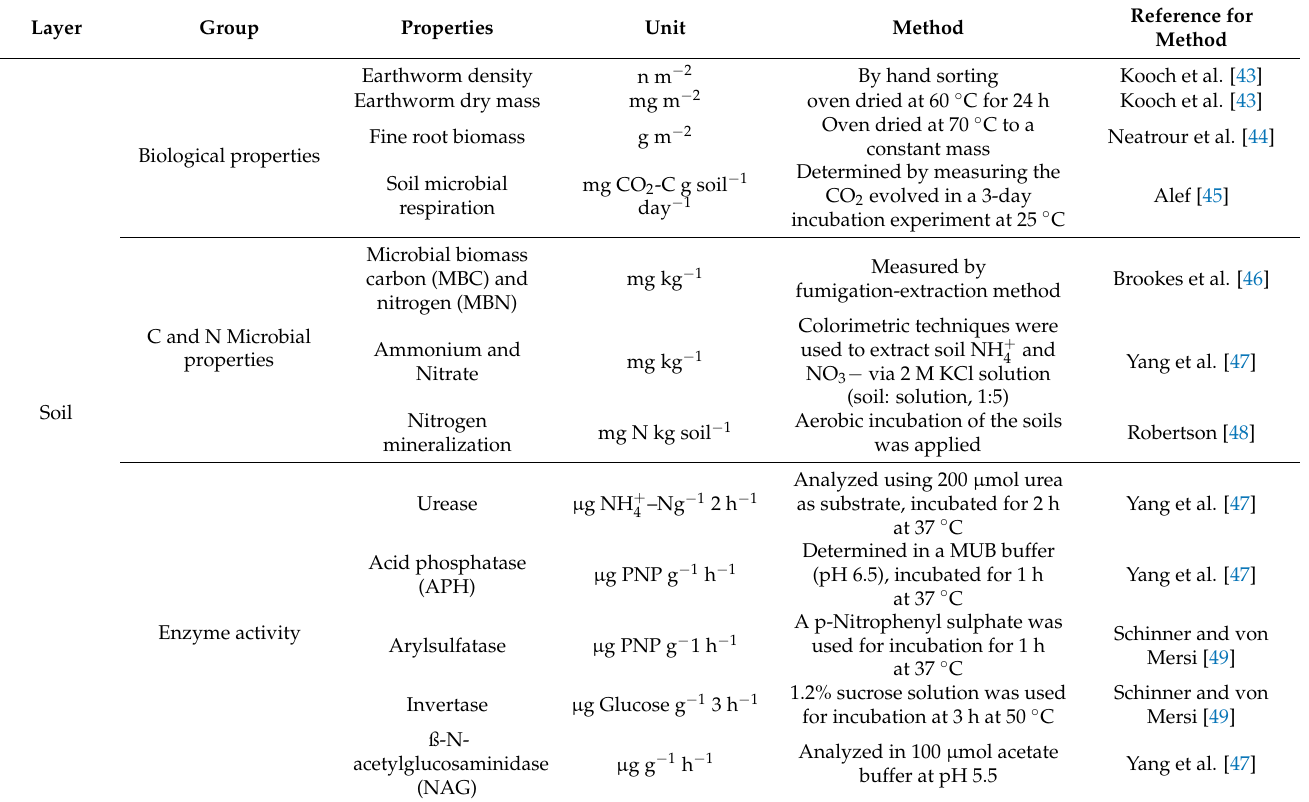
Table 3. Methods of analyzing soil biochemical, biological and microbial properties, enzyme activity, and